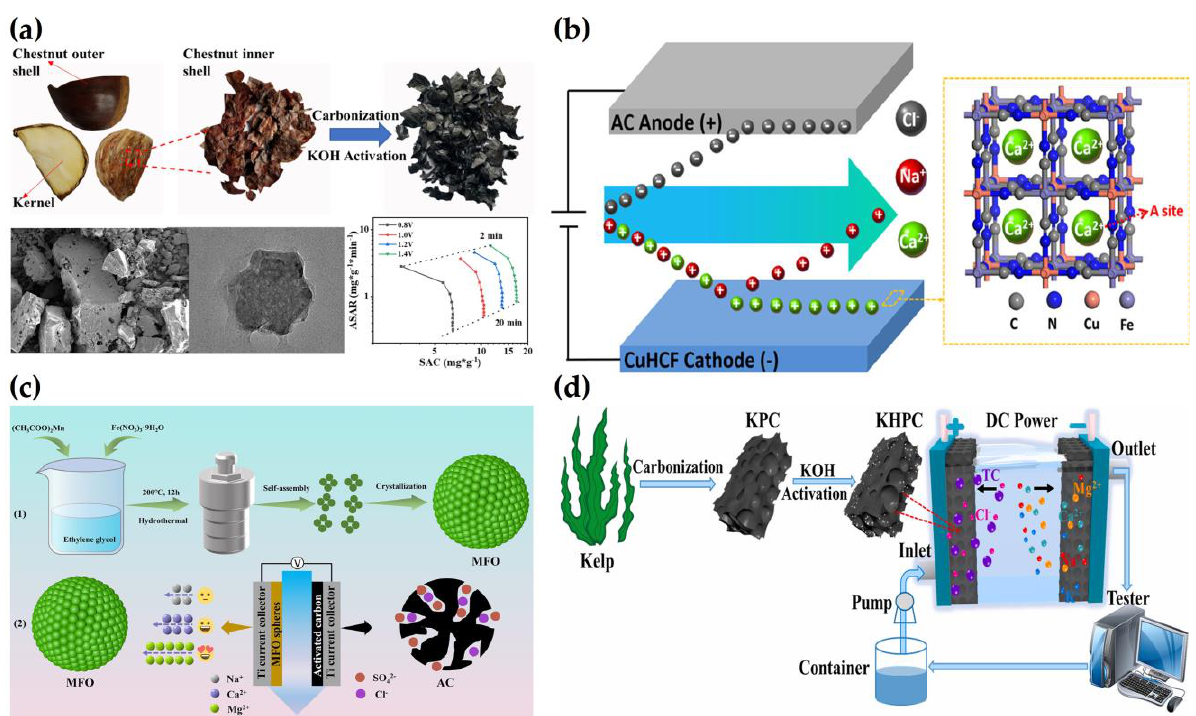
Figure 4. ( a ) Fabrication of CSx from chestnut inner shell and Structure diagram of CS500 [76]. Copyright 2022, Elsevier. ( b ) Application of CuHCF electrode material in hard water treatment [73]. Copyright 2020, American Chemical Society. ( c ) (1) Schematic illustration of the preparation of MFO nanospheres; (2) Schematic illustration of selective ion electro-sorption of the MFO electrode in the PHCDI system [77]. Copyright 2021, American Chemical Society. ( d ) Simultaneous removal of TC and hardness ions from water using the KHPC electrodes with a symmetrical CDI device [85]. Copyright 2021,